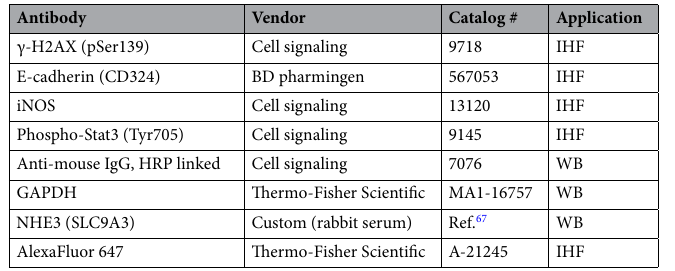
Table 2. Antibodies used in this work. IF-immunofluorescence, WB Western